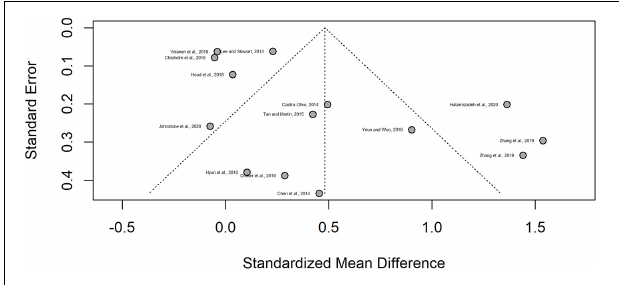
FIGURE 5 | Publication risk funnel plot.